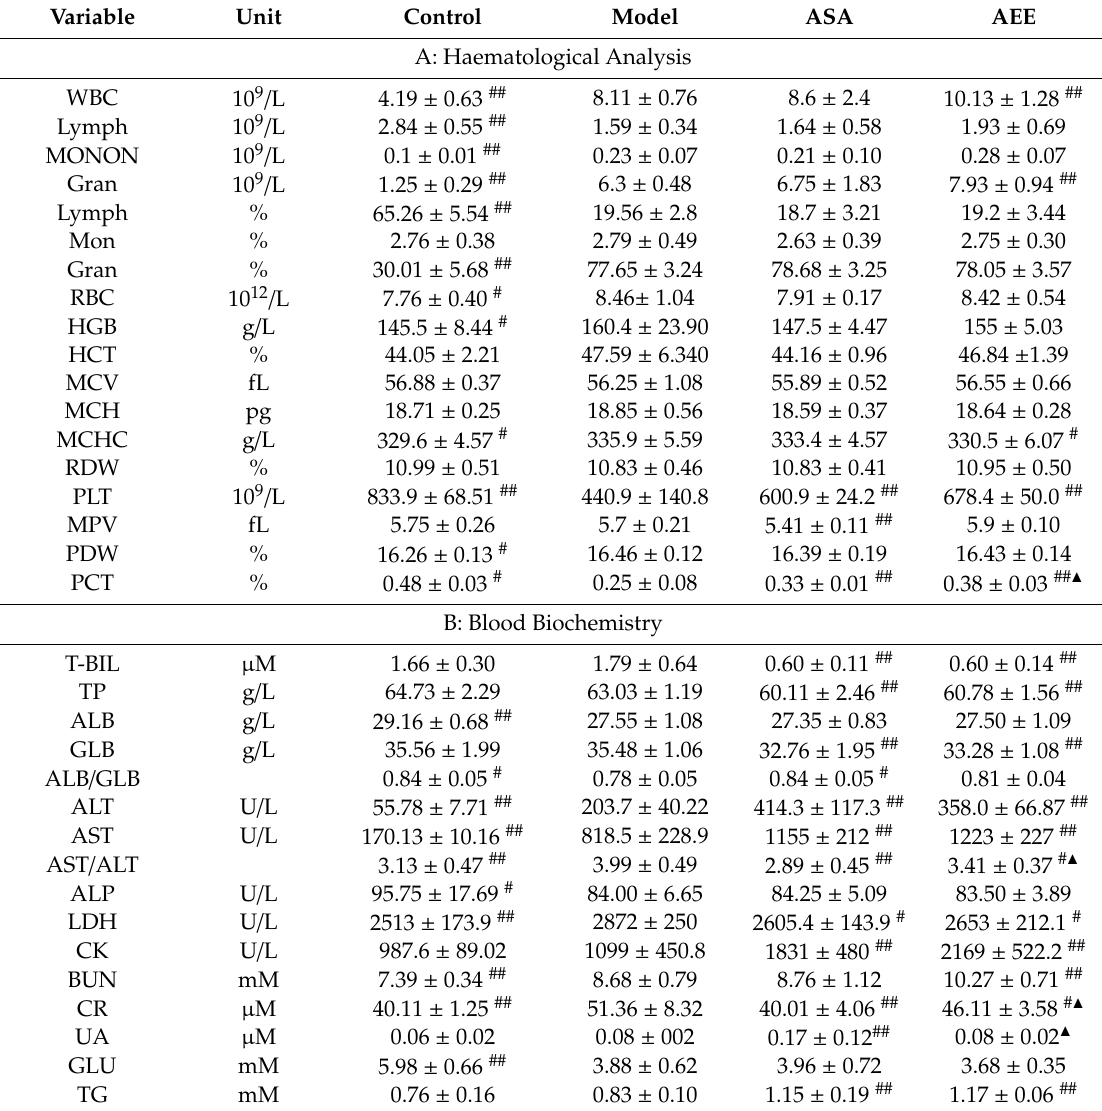
Table 2. E ff ects of AEE on haematological analysis ( A ) and blood biochemistry ( B ).